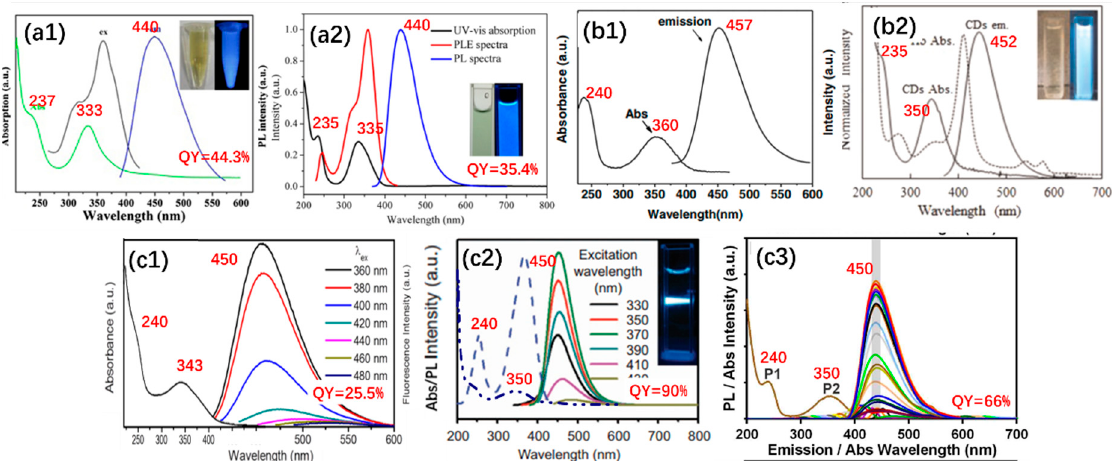
Figure 3. The optical properties of different CDs. CDs in ( a1 , Ref. [37]) and ( a2 , Ref. [38]) are synthesized from CA and ammonia by microwave method and hydrothermal treatment, respectively. CDs in ( b1 , Ref. [39]) and ( b2 , Ref. [40]) are synthesized from CA and ethylenediamine by microwave method and hydrothermal treatment, respectively. CDs in ( c1 , Ref. [41]), ( c2 , Ref. [42]), and ( c3 , Ref. [43]) are synthesized from CA and diethylenetriamine by thermal decomposition and hydrothermal treatment, respectively. Reproduced from Ref. [37–43] with permission of Copyright (2016, 2018) American Chemical Society, Copyright (2015, 2016, 2018) Elsevier, Copyright (2013) Springer, and Copyright (2015) Nature Publishing Group, respectively.